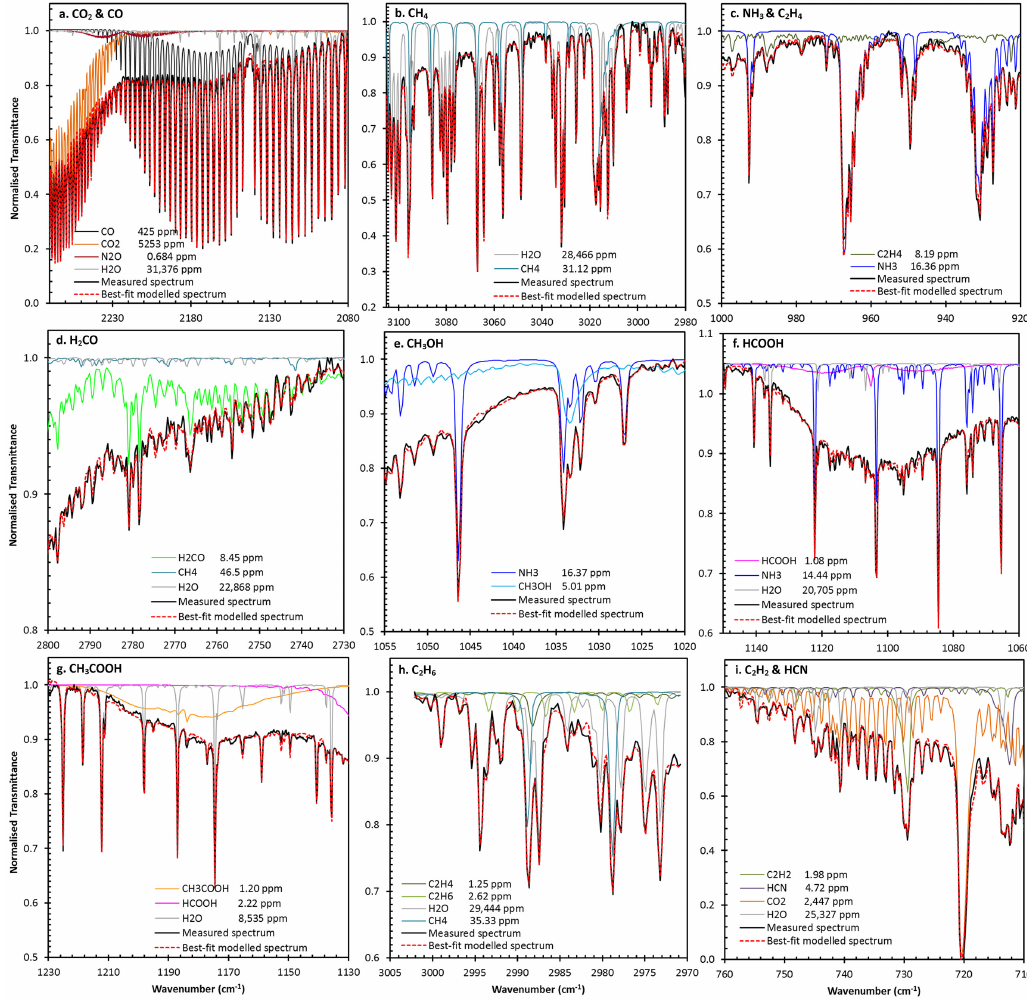
Figure 2. Typical retrieval spectral windows for each of the trace gases retrieved for this paper: (a) CO 2 and CO; (b) CH 4 ; (c) C 2 H 4 and NH 3 ; (d) H 2 CO; (e) CH 3 OH; (f) HCOOH; (g) CH 3 COOH; (h) C 2 H 6 ; and (i) C 2 H 2 and HCN. The measured spectrum (black line) and the best-fit modelled spectrum (dashed red line) are shown along with each of the individually modelled trace gas spectra (multiple colours). The modelled spectrum is the sum of each of the individual trace gas spectra convolved to the background polynomial (see Table 1 in Paton-Walsh et al.,